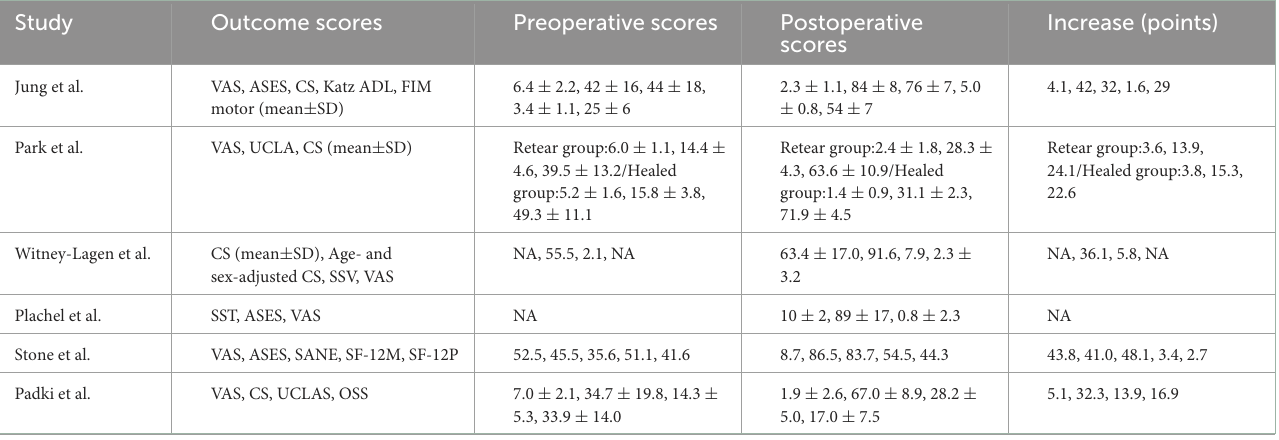
TABLE 3 Outcome